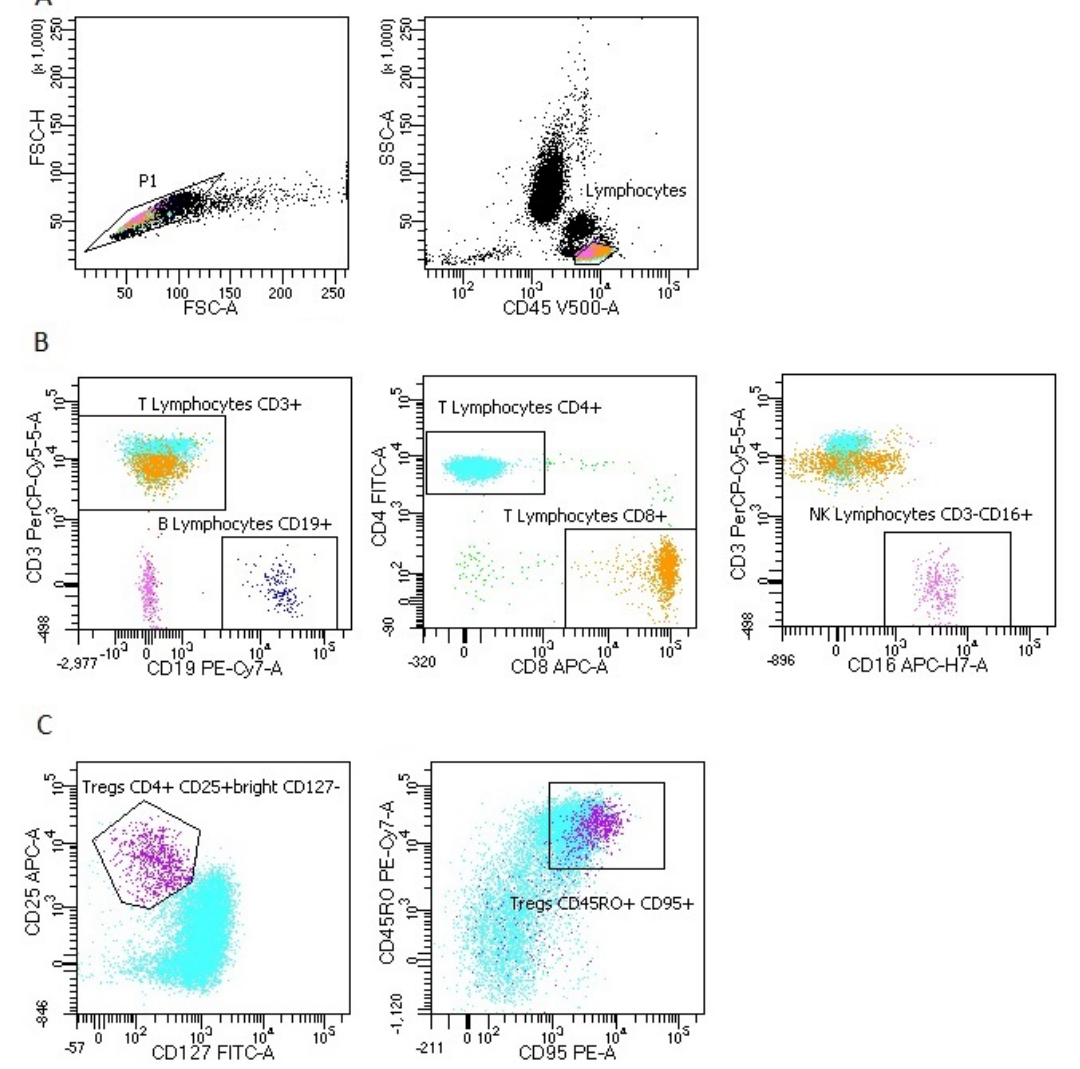
Figure A2. Representative FACS analysis of PB cells with antibodies specific for lymphocytes subpopulations and T reg- ulatory (Treg) cells. ( A ) Lymphocytes gating strategy: FSC-A vs. FSC-H plot: Gating the cells that have an equal area and height, thus removing clumps (greater FSC-A relative to FSC-H) and debris (very low FSC), CD45 vs. SSC-A plot: Selection of lymphocytes based on their SSC/CD45+ properties. ( B ) Lymphocyte subpopulation gating strategy: CD3 vs. CD19 plot: Selection of lymphocytes T (blue and yellow) based on their CD3+ properties and lymphocytes B (navy blue) based on their CD19+ properties. CD4 vs. CD8 plot: Selection of T lymphocytes subsets CD4+ (blue) and CD8+ (yellow) based on their CD4/CD8 properties. CD3 vs. CD16 plot: Selection of NK cells (pink) based on their CD16+ properties and CD3 negative. ( C ) Treg cells and Tregs subsets gating strategy: CD25 vs. CD127 plot: Selection of Treg cells (purple) based on their CD25+high and CD127 negative properties. CD45RO vs. CD95 plot: Treg cells subset with CD45RO and CD95 ex- pression. References 1. Chauhan, S. Comprehensive review of coronavirus disease 2019 (COVID-19). Biomed. J. 2020 , 43 , 334 – 340, doi:10.1016/j.bj.2020.05.023.